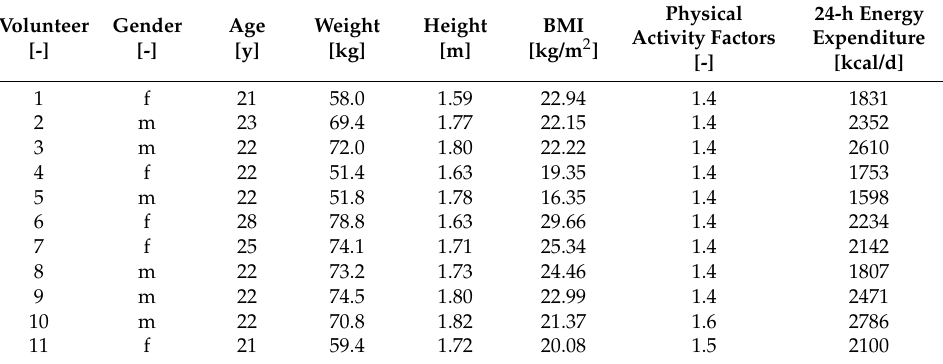
Table 2. Demographic and anthropometric data as well as calculated energy expenditures of the